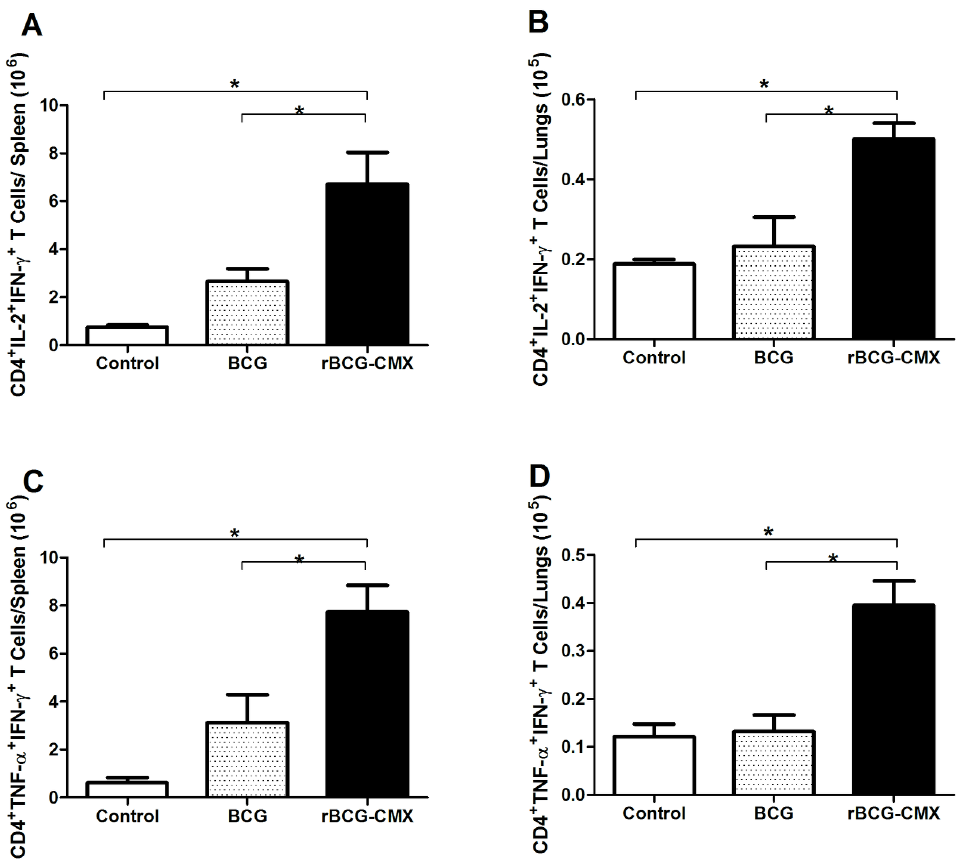
Figure 7. Levels of polyfunctional CD4 + T cells induced by BCG and rBCG-CMX vaccines. Spleen (A and C) and lung (B and D) cell suspensions from vaccinated and control mice stimulated with rCMX. (A–B) CD4 + IL-2 + IFN- c + cells or (C–D) CD4 + TNF- a + IFN- c + cells were analyzed by flow cytometry. Lymphocytes were selected based on size and granularity. Gates were set to analyze CD4 + T cells, and then the fluorescence of antibodies detecting IL-2 + and IFN- c + or TNF- a + and IFN- c + cells was recorded. These data are representative of two independent experiments (N=6, *p , 0.05).